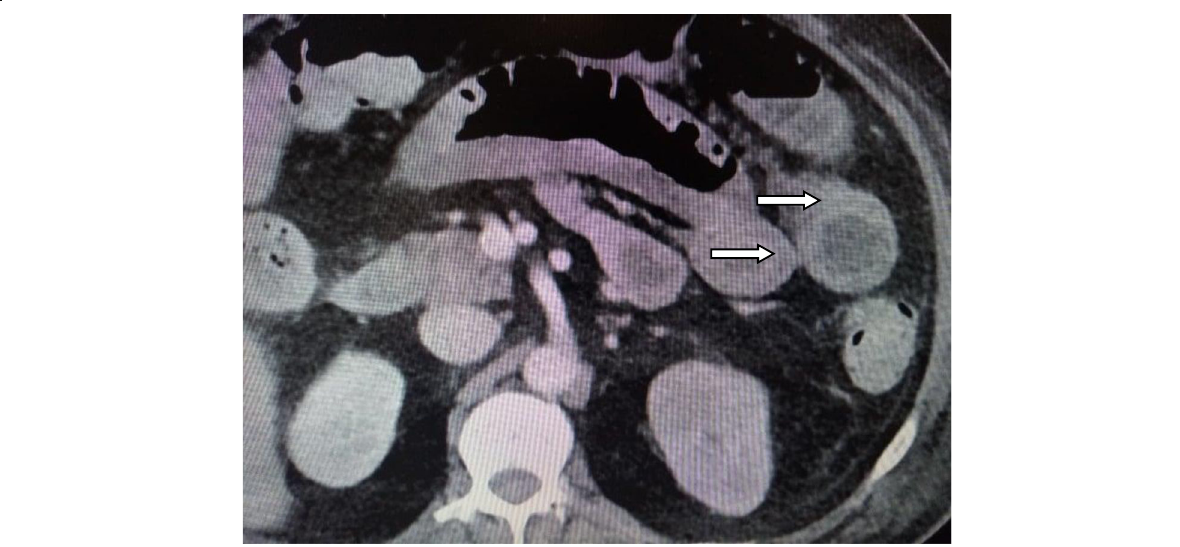
Fig. 4 Fifty-eight-year-old COVID-19 male patient isolated in the medical ward then presented with abdominal distention. MDCT study shows positive target sign in small bowel loop segments in the left side of the abdomen (arrows) with submucosal edema and mucosal